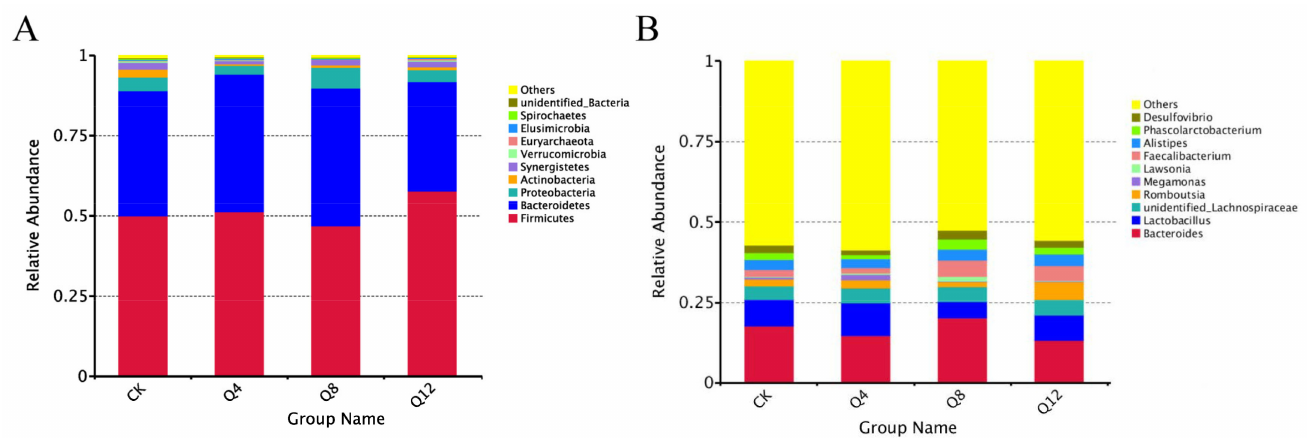
Figure 2. Distribution of microbial abundance. Notes: ( A ) Microbe abundance distribution at phylum level; ( B ) Abundance distribution of genus-level